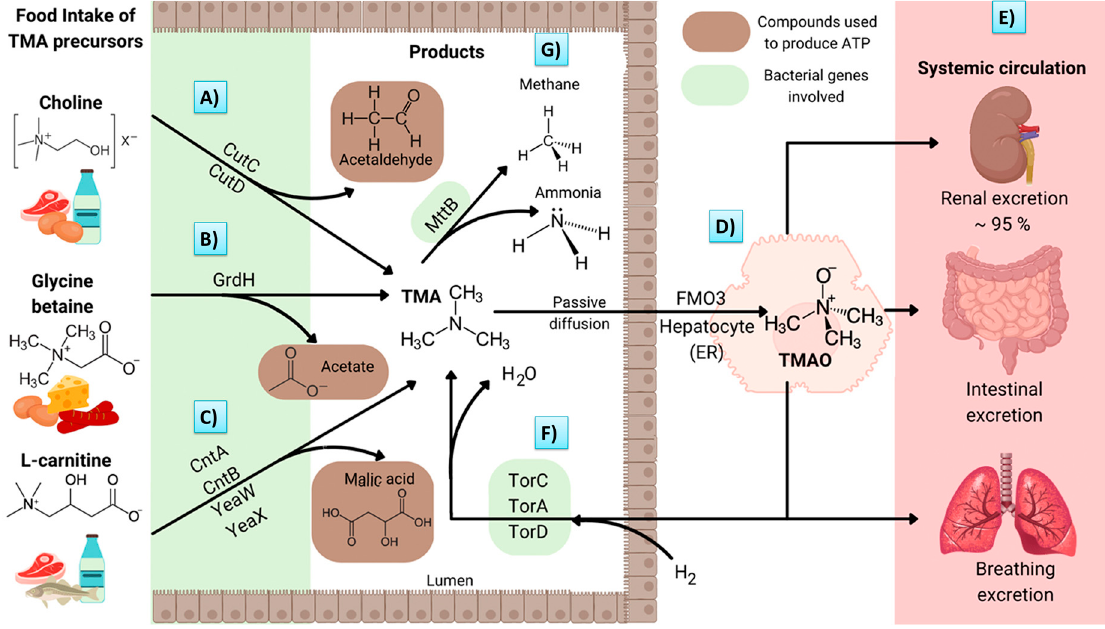
Figure 1. Illustration of the biosynthesis and metabolism of TMAO and the associated genes. Pre- cursors of TMA, ( A ) choline, ( B ) glycine betaine, and ( C ) L-carnitine, are ingested in certain foods. They are then catabolized by the gut microbiota to obtain the end products (e.g., TMA) utilized in the formation of ATP. ( D ) Afterwards, 95% of TMA is diffused and oxidized by FMO3 in the liver; ( E ) subsequently, it is transported to other organs via systemic circulation. ( F ) TMAO can serve as a final electron acceptor in bacteria that colonize the gut, thus reducing TMAO to TMA and H 2 O. Alternatively, TMA is used by some methanobacteria to generate methane and ammonia. ( G ) Trimethylamine N-oxide is represented by TMAO, trimethylamine is represented by TMA, endo- plasmic reticulum is represented by ER, and flavin-containing monooxygenase 3 is represented by FMO3. (Created with canva.com and BioRender.com). Table 1. Bacterial genes related to TMAO metabolism.